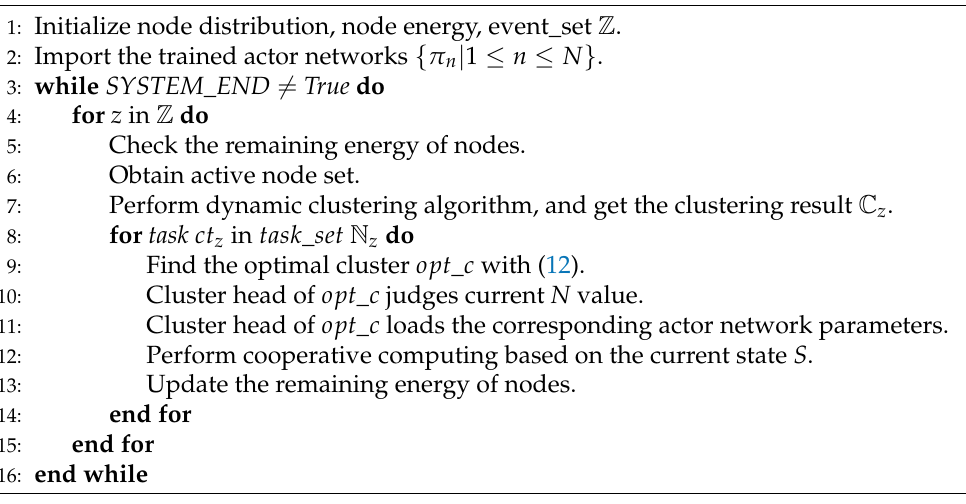
Algorithm 3 Inference of DDPG